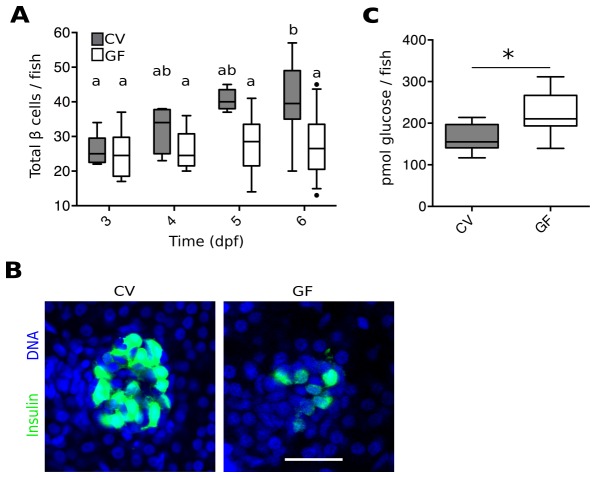
The microbiota are required for normal expansion of the larval β cell mass.(A) Total number of β cells per larva in GF (white box plots) and CV (grey box plots) fish at 3, 4, 5 and 6 dpf. In this, and in all subsequent figures, CV data are shown in grey box plots, and GF data, or statistically similar treatment groups, are shown in white box plots. In all relevant panels and remaining figures, box plot whiskers represent the 95% confidence interval of the data set. Single factor ANOVA indicates that gnotobiology of the fish was significant in determining the number of β cells present (F7=9.01, p=1.45e−8). Labels a, ab and b indicate the results of post hoc means testing (Tukey). The difference between GF and CV cell counts became significant at 6 dpf (t=−5.91, p<0.001). (B) Representative 2D slices from confocal scans through the primary islets of 6 dpf CV and GF Tg(-1.0insulin:eGFP) larvae. Each slice is taken from the approximate center of the islet structure. Insulin promoter expressing β cells are in green and nuclei are blue. Scale bar = 40 μM. (C) The average amount of glucose (pmol) per larva aged 6 dpf (* t17=−3.65, p<0.01).DOI:
http://dx.doi.org/10.7554/eLife.20145.00310.7554/eLife.20145.004Figure 1—source data 1.Quantifications and statistical analysis of larval β cells corresponding to Figure 1A.Exact values of N, mean, median, SD, and SEM are reported in the source data file and are highlighted in yellow, magenta, blue, green, and cyan, respectively.DOI:
http://dx.doi.org/10.7554/eLife.20145.00410.7554/eLife.20145.005Figure 1—source data 2.Quantifications and statistical analysis of 6 dpf larval free glucose levels corresponding to Figure 1C.Exact values of N, mean, median, SD, and SEM are reported in the source data file and are highlighted in yellow, magenta, blue, green, and cyan, respectively.